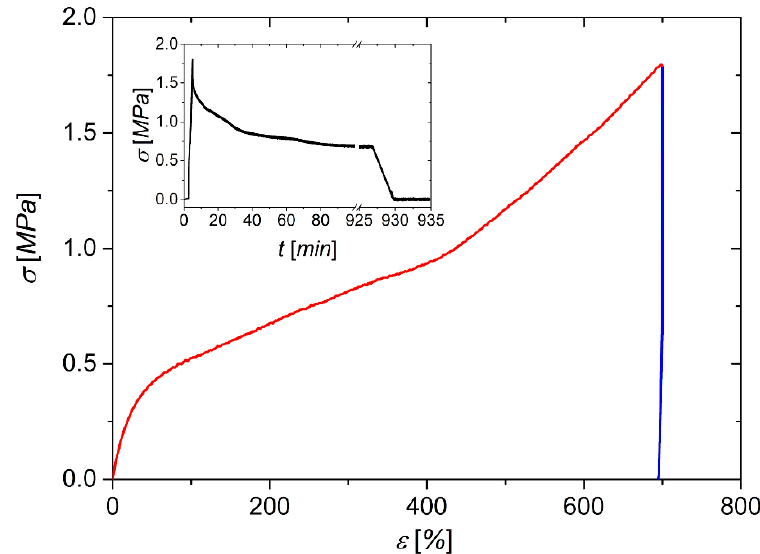
Figure 6. Stress–strain behavior of PDA-based PEU when programming the 2 W SME. The individual steps consisted of elongation at T d = 75 °C (red color, strain rate = 300%·min –1 ) followed by slow cooling and unloading at 23 °C (blue color, unloading rate = 1 N·min –1 ). The inset shows the evolution of stress over time for a longer period before unloading was carried out.